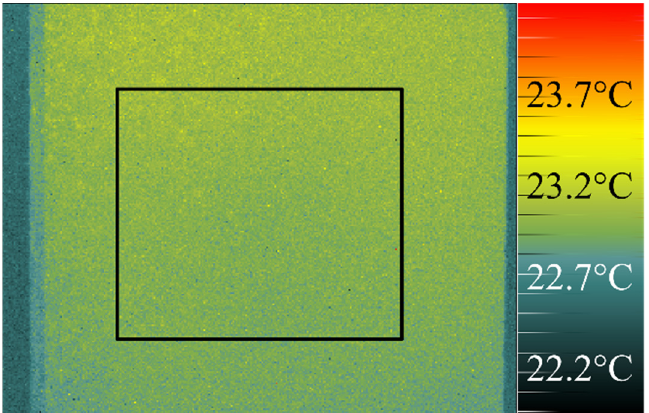
Figure 14. Thermogram of the dry type 1 sample before pulse heating. The black rectangle indicates the region used for extraction of the transient.